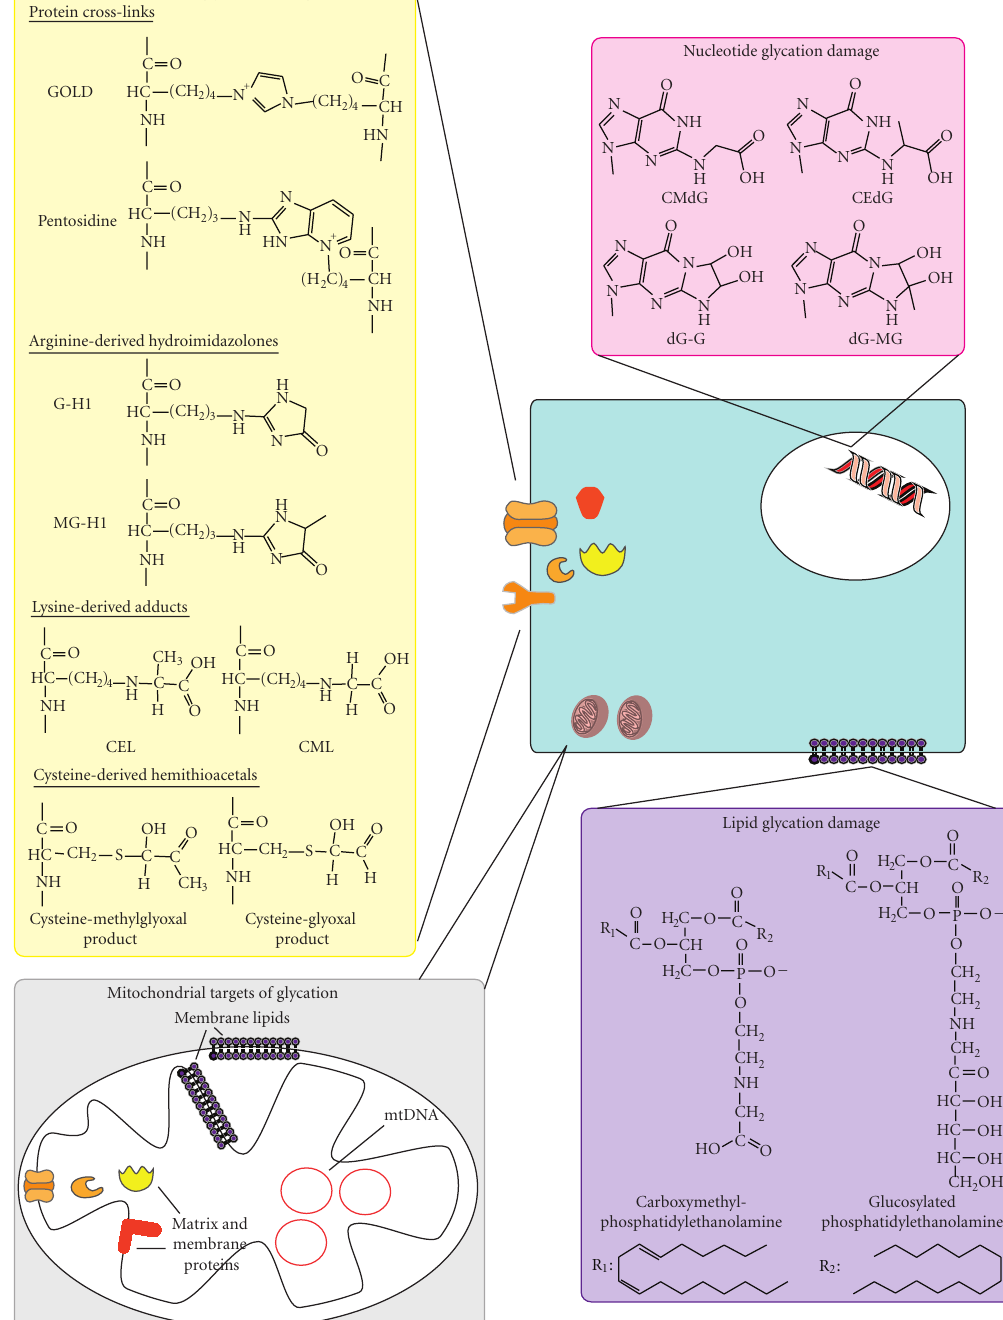
Figure 1: Reactive α , β -dicarbonyl-induced glycation damage in cells. Glycation by α , β -dicarbonyls like methylglyoxal and glyoxal a ff ects all classes of biological macromolecules. Proteins, in particular arginine, lysine, and cysteine residues, are highly susceptible to glycation, forming protein cross-links and various AGE adducts, examples of which are shown here. Of these, the most important protein-AGEs quantitatively are arginine-derived hydroimidazolones, especially MG-H1. Formation of protein AGEs alters protein structure and function, leading to biochemical dysfunction. Nucleotides and lipids may also undergo glycation, with deoxyguanosine and basic phospholipids being particularly vulnerable. Consequences of nucleotide and lipid glycation damage are increased DNA mutations and compromised lipid membrane integrity, respectively. Within mitochondria, it is expected that glycation a ff ects matrix and membrane proteins, phospholipids on the outer and inner mitochondrial membranes and